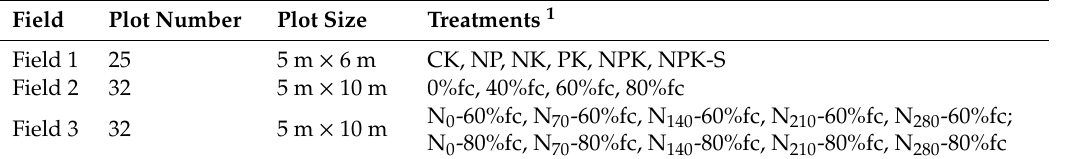
Figure 1. ( a ) Location of Shandong Province in China; ( b ) location of the Yucheng Comprehensive Experiment Station (YCES, Chinese Academy of Sciences) in Shandong Province; ( c ) Overview of the three long-term experimental fields in YCES. Table 1. Treatments used in the three experimental